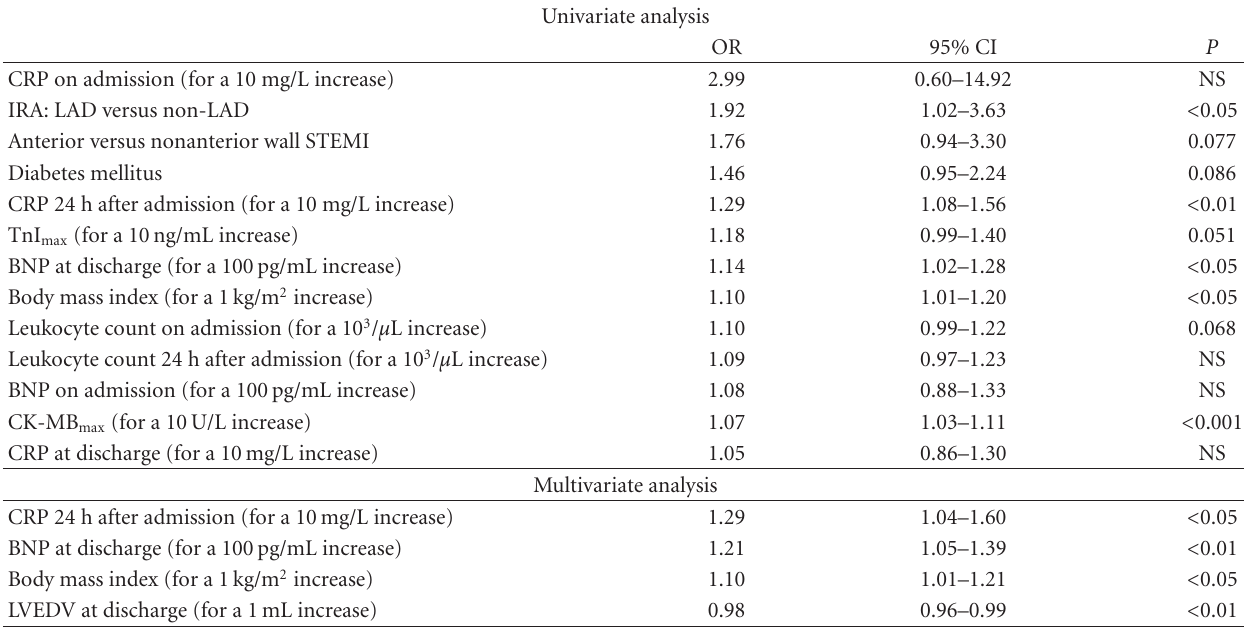
Table 4: Predictors of postinfarct left ventricular remodelling in univariate and multivariate analyses. Univariate analysis shows demo- graphic, clinical, angiographic, biochemical, and discharge echocardiographic parameters from Tables 1–3 with a P value < 0.1 as well as BNP, CRP, and leukocyte count independently of their P values, while results of multivariate analysis are restricted to variables with a P value < 0.05. Results are presented according to decreasing values of odds ratios.